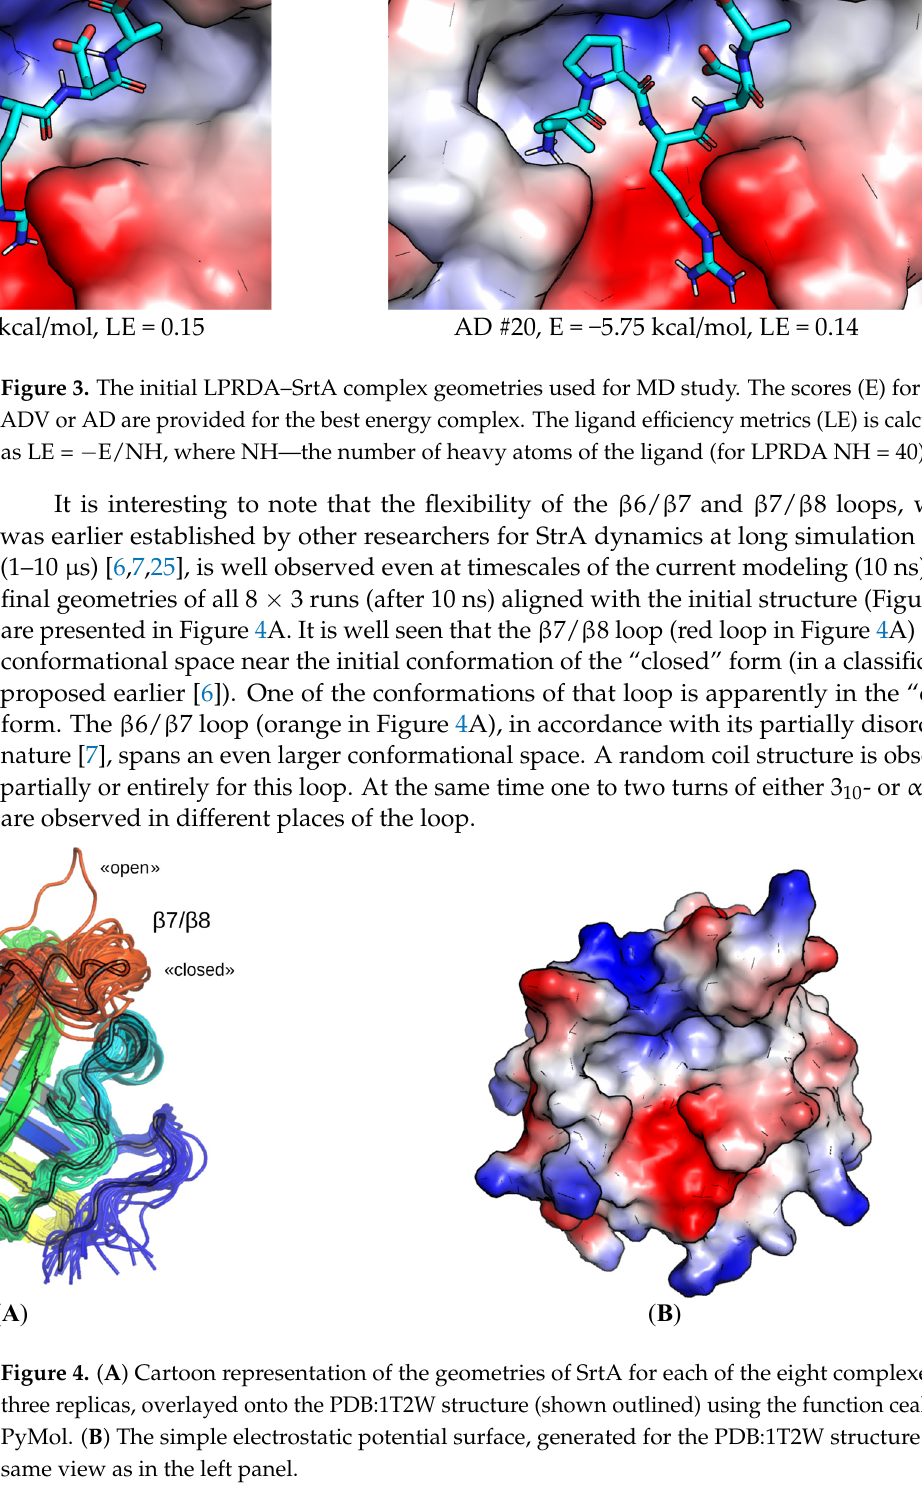
Figure 3. The initial LPRDA–SrtA complex geometries used for MD study. The scores (E) for either ADV or AD are provided for the best energy complex. The ligand efficiency metrics (LE) is calcu- lated as LE = -E/NH, where NH—the number of heavy atoms of the ligand (for LPRDA NH = 40).